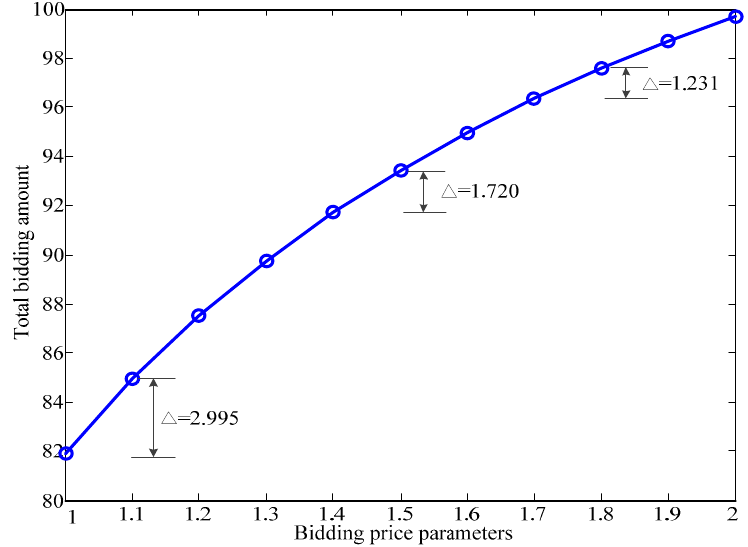
Figure 9. Bidding amount and population for different bidding price parameters. 485